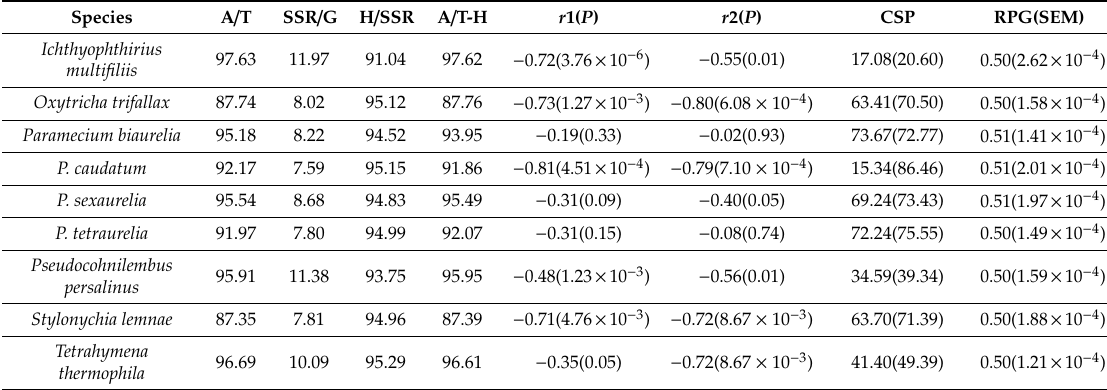
Table 2. Macronuclear simple sequence repeats